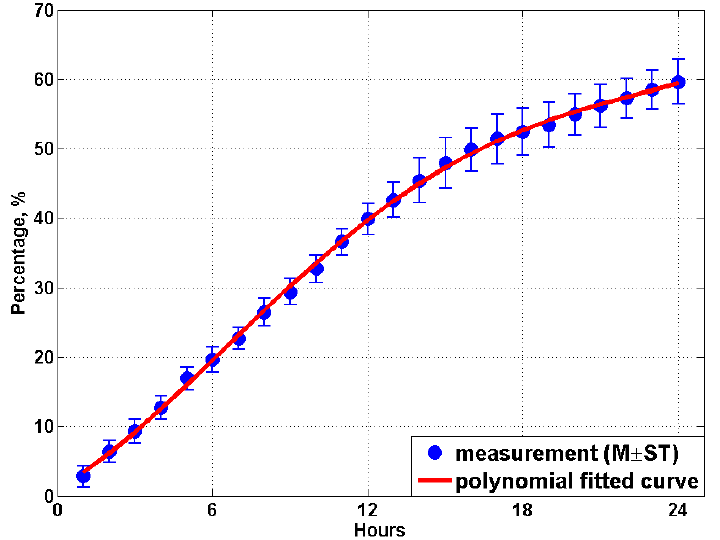
Figure 9. The measured manure coverage proportion with time and polynomial fit curve within 24 h. Mean values (M) and standard deviations (ST) are calculated based on all 21 weeks’ data.